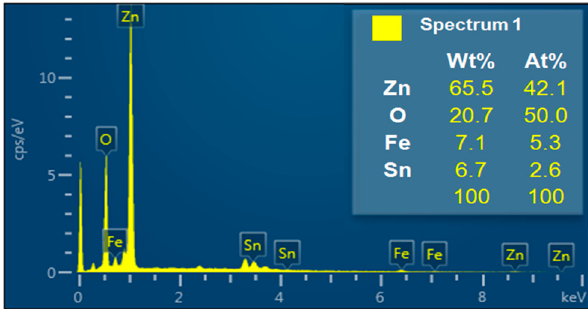
Figure 7. Energy dispersive X-ray spectroscopy (EDS) analysis of ZnO NW vines decorated with 0.05-M α -Fe 2 O 3 on ITO.